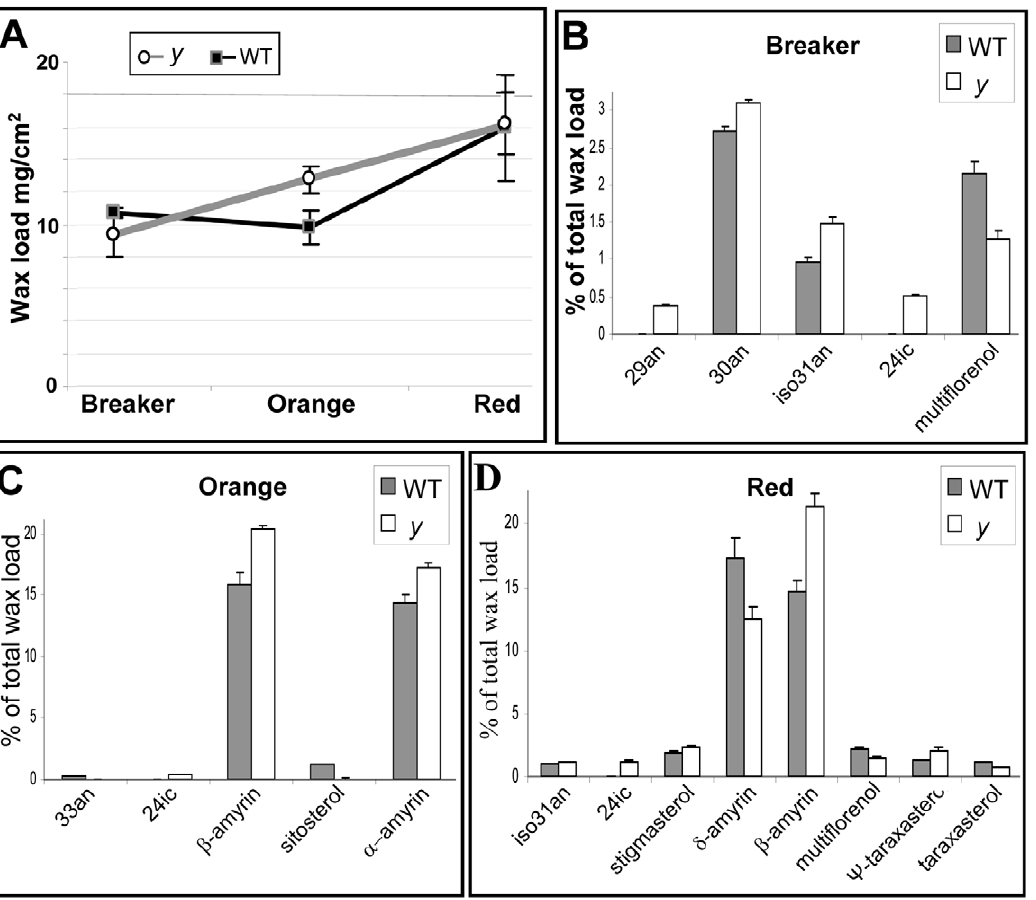
Figure 6. Composition of the y mutant and wt fruit cuticular waxes was tested at three stages of fruit development, analyzed by GC-MS and GC-FID (n=5; P , 0.05; bars indicate standard errors). (A) Total cuticular wax load expressed as mg/cm 2 . (B) Amounts (%) relative to total wax coverage of individual compounds that were significantly altered at the breaker stage of fruit development, (C) at the orange stage of fruit development, and (D) at the ripe red stage of fruit development. 29an, C 29 alkane; 30an, C 30 alkane; iso31an, C 31 iso alkane; 24ic, tetracosanoic acid.